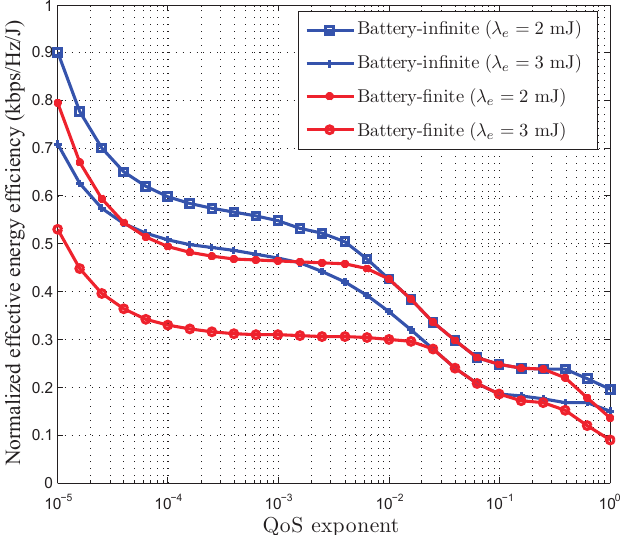
Figure 8. The normalized effective energy efficiency of our developed QoS-driven power control policies versus QoS exponent in battery-infinite and battery-finite energy harvesting based wireless sensor networks.